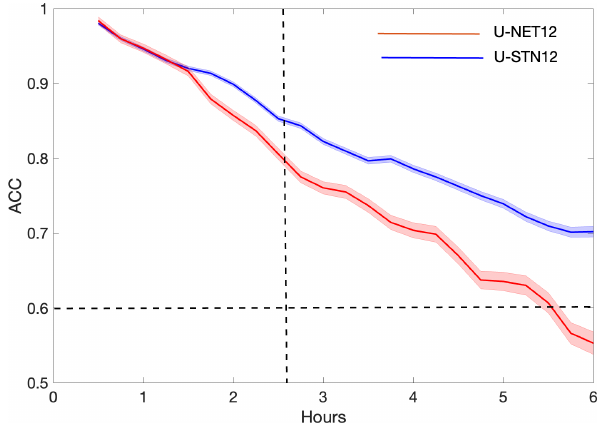
Figure A1. Performance of U-STN12 and U-NET12 on T850. Shading represents standard deviation over 30 initial